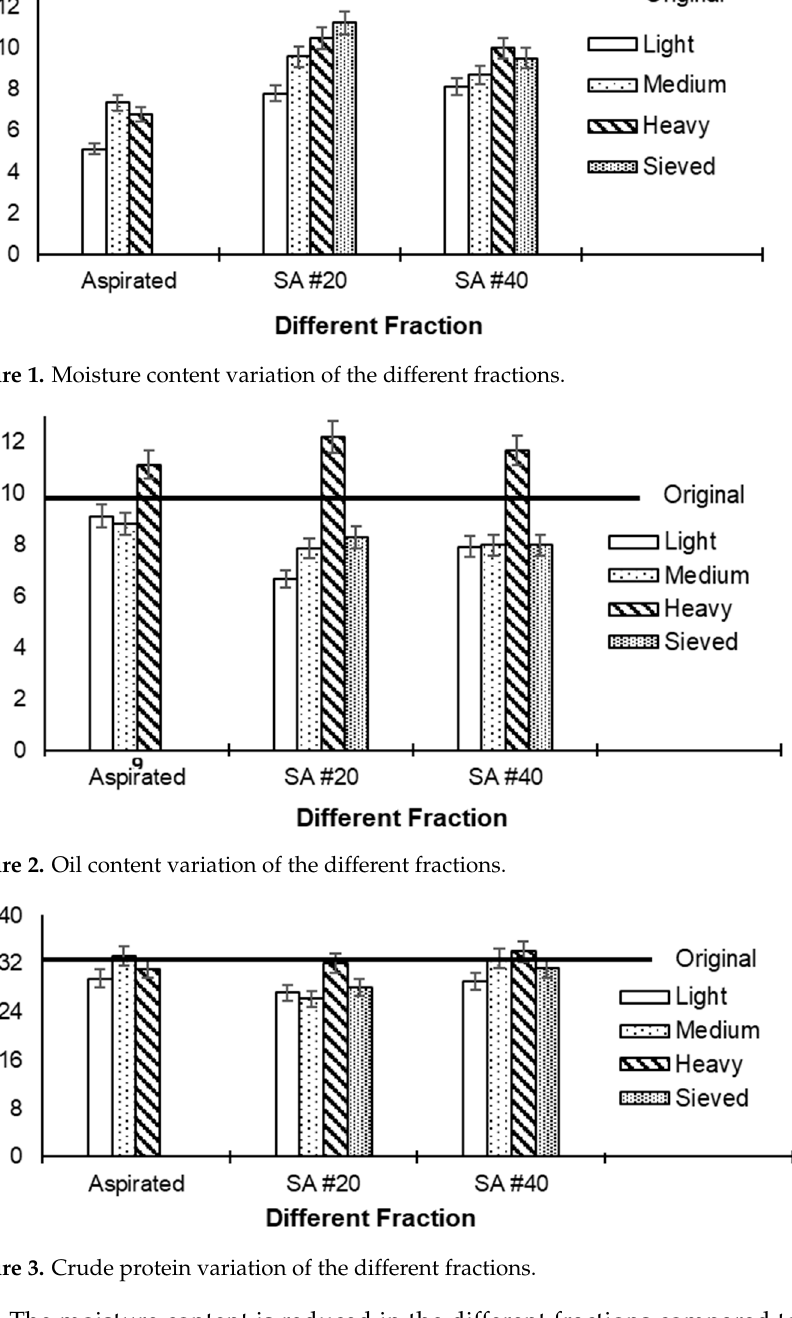
( c ) Figure 4. Samples used for different experiments; ( a ) original DDGS; ( b ) #20-sieved aspirated (SA) heavy fraction; ( c ) #40-sieved aspirated (SA) heavy fraction.